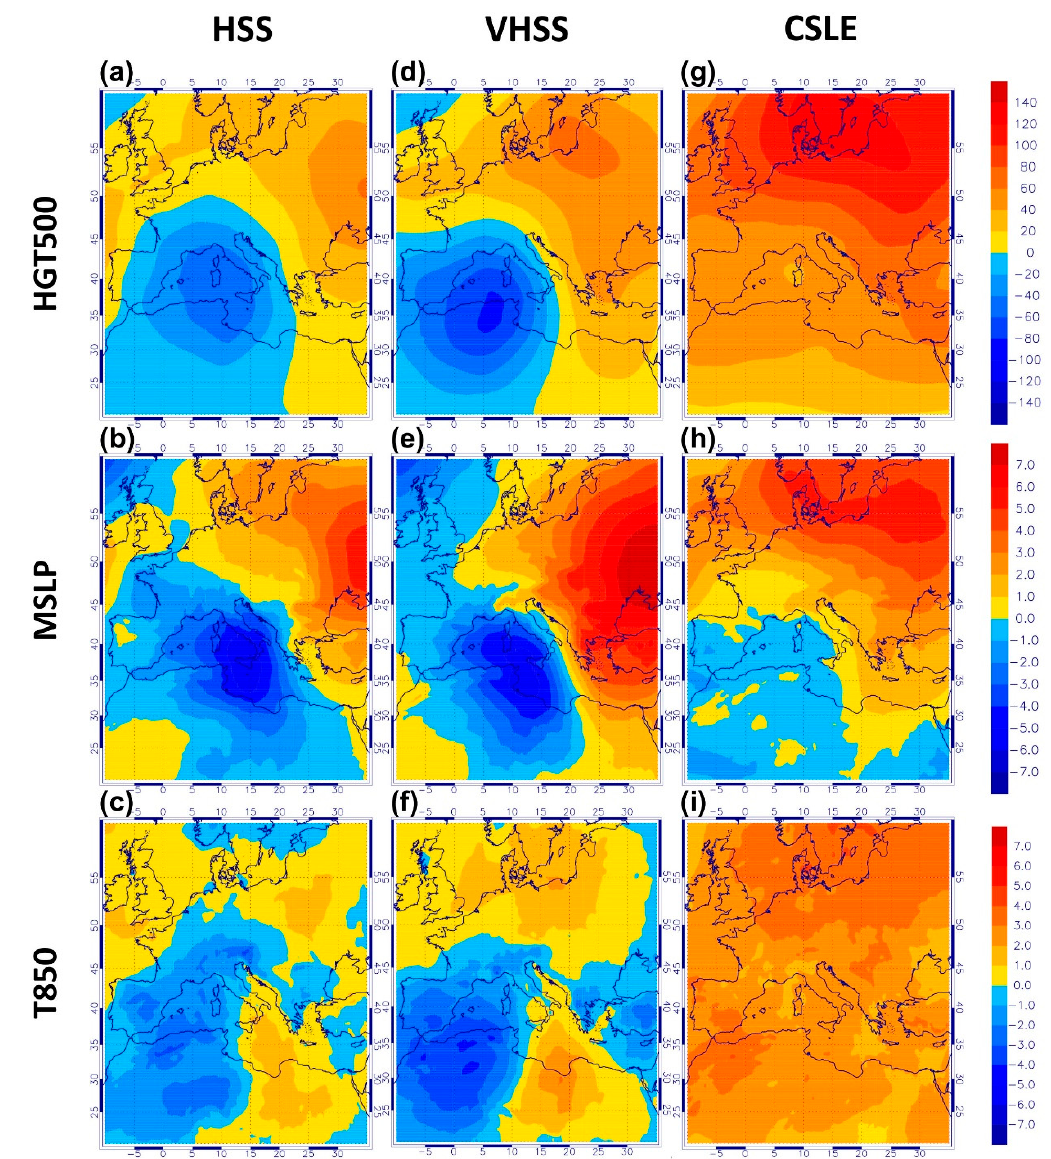
Figure 12. Differences between the averaged fields of geopotential height (m) at 500 hPa, for HSS, and the whole considered period of 14 years ( a ); differences between the averaged fields of mean sea level pressure (hPa), for HSS, and the whole considered period of 14 years ( b ); differences between the averaged fields of temperature at 850 hPa (K), for HSS, and the whole considered period of 14 years ( c ); for VHSS ( d ) as ( a ); for VHSS ( e ) as ( b ); for VHSS ( f ) as ( c ); for CSLE ( g ) as ( a ); for CSLE ( h ) as ( b ); for CSLE ( i ) as ( c ). The maps are generated using Copernicus Climate Change Service Information (2002–2015).